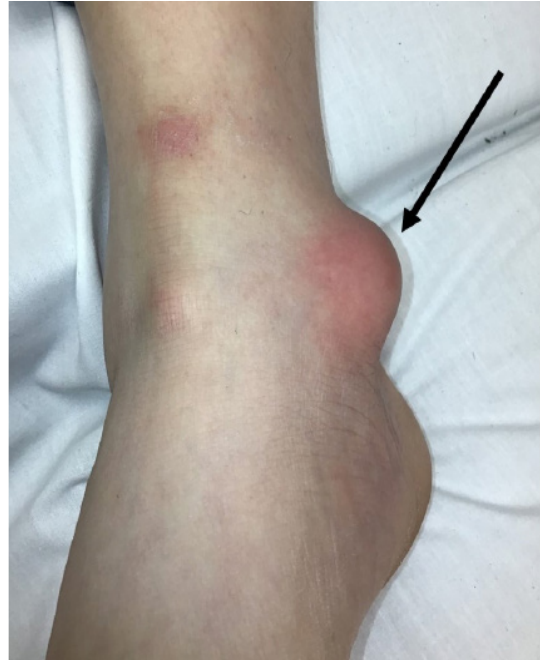
Image 1. Localized swelling and erythema over the medial malleolus